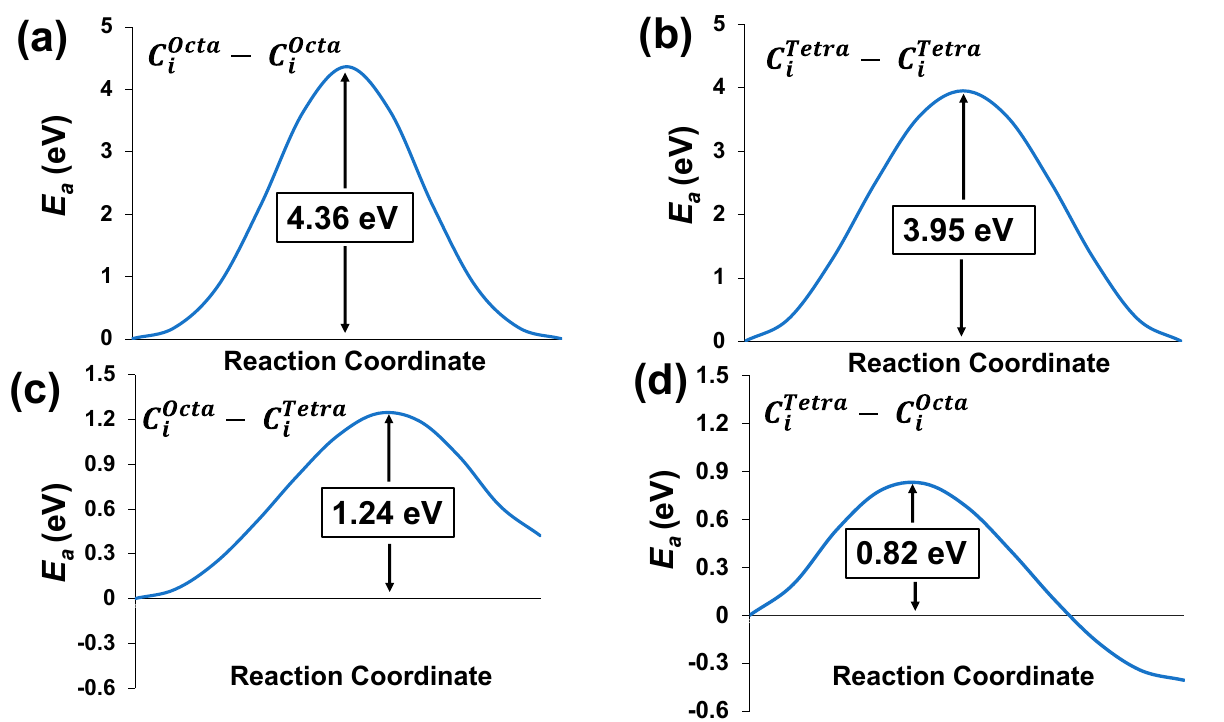
Figure 3. Calculated activation energy for diffusion of carbon in a Pb matrix moving from ( a ) 𝐶 (cid:3036)(cid:3016)(cid:3030)(cid:3047)(cid:3028) − 𝐶 (cid:3036)(cid:3016)(cid:3030)(cid:3047)(cid:3028) , ( b ) 𝐶 (cid:3036)(cid:3021)(cid:3032)(cid:3047)(cid:3045)(cid:3028) − 𝐶 (cid:3036)(cid:3021)(cid:3032)(cid:3047)(cid:3045)(cid:3028) , ( c ) 𝐶 (cid:3036)(cid:3016)(cid:3030)(cid:3047)(cid:3028) − 𝐶 (cid:3036)(cid:3021)(cid:3032)(cid:3047)(cid:3045)(cid:3028) , and ( d ) 𝐶 (cid:3036)(cid:3021)(cid:3032)(cid:3047)(cid:3045)(cid:3028) − 𝐶 (cid:3036)(cid:3016)(cid:3030)(cid:3047)(cid:3028) sites (note: Y -axes in the figure are not to the same scale).